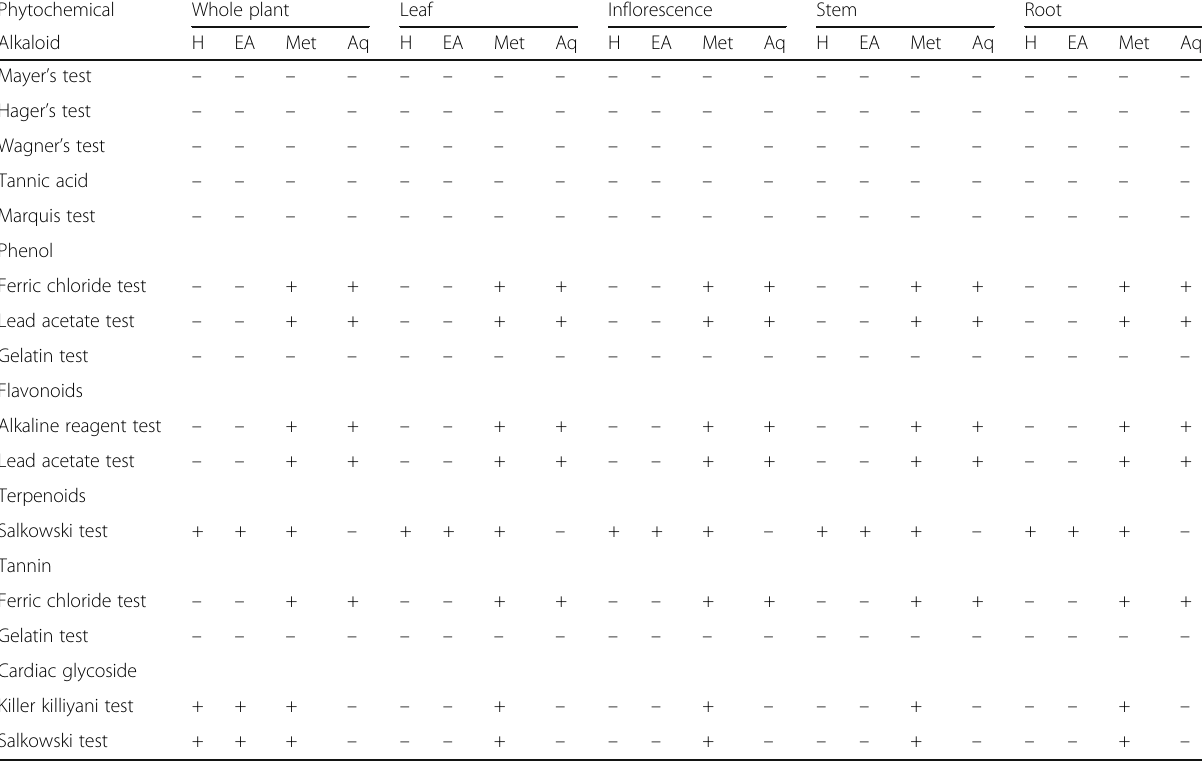
Table 5 Phytochemical analysis of different parts of Sphaeranthusindicus extracted in various solvents